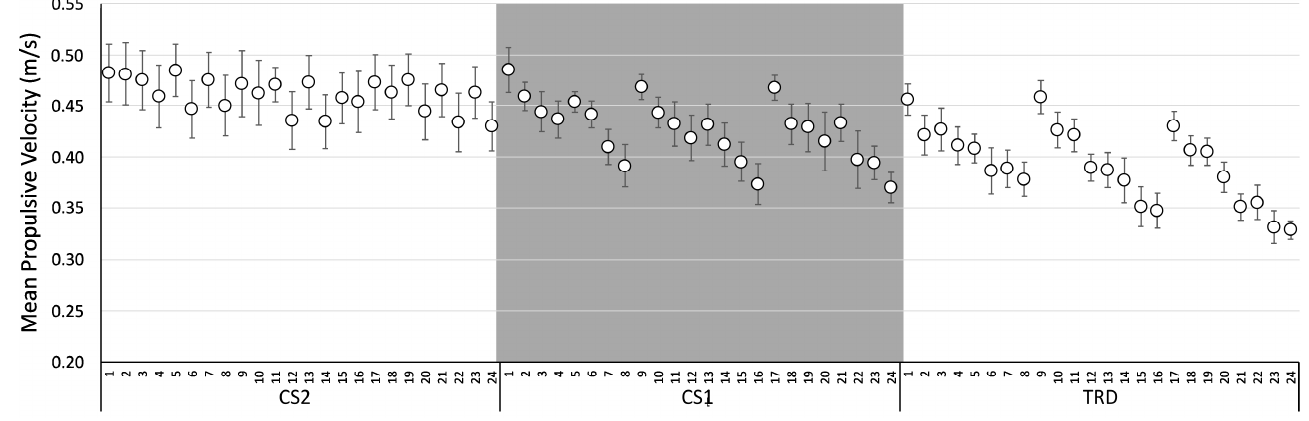
Figure 4. Mean Propulsive Velocity for Protocols CS2 (Cluster 2), CS1 (Cluster 1), and TRD (Traditional). Data are expressed as mean values and standard error.